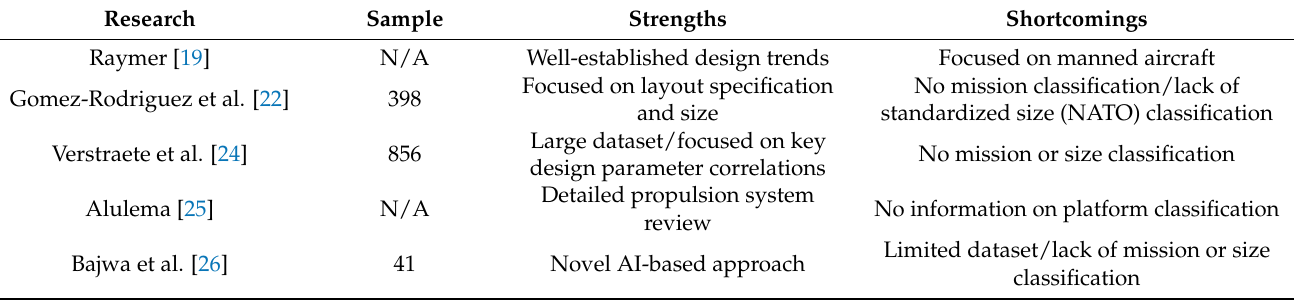
Table 1. Previous UAV database